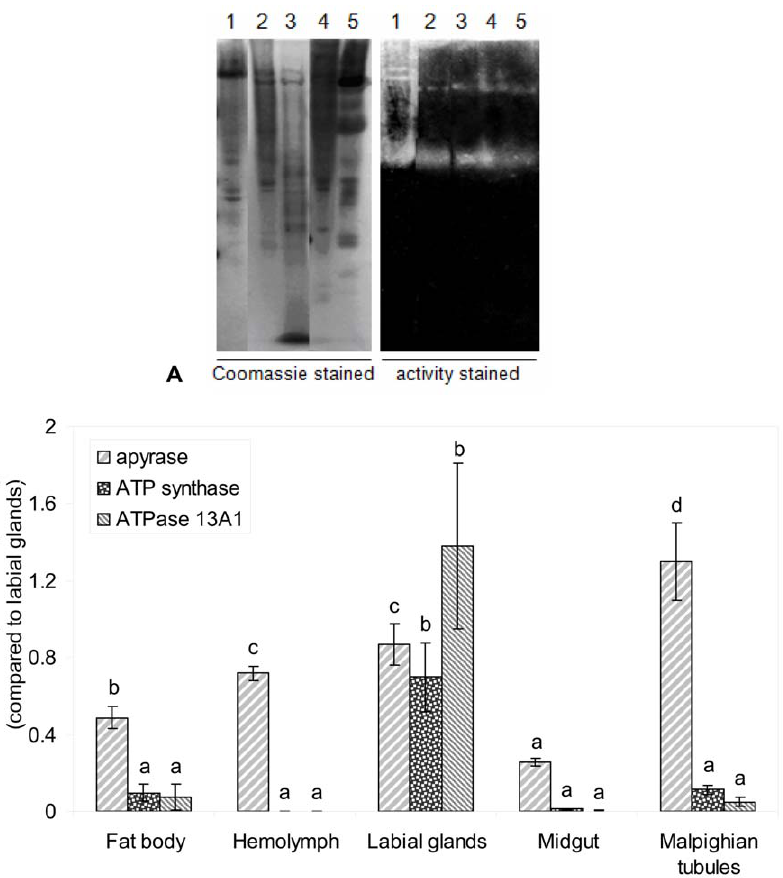
Figure 1. Activities and expressions of ATP hydrolyzing enzymes in H.zea tissues. A , in-gel ATP hydrolysis activity test among different tissues of H. zea . Lane 1–5, total crude homogenates from labial glands, fat body, hemolymph, Malpighian tubules and midgut, respectively. B , the relative expression levels of three target genes among different tissues of H. zea . Actin was used as the internal reference. Values are expressed as mean 6 SE (n=3). Significance was tested for each gene separately. Different letters above each bar indicate statistical difference determined by ANOVA analysis followed by the Duncan’s Multiple Range Test (P , 0.05).